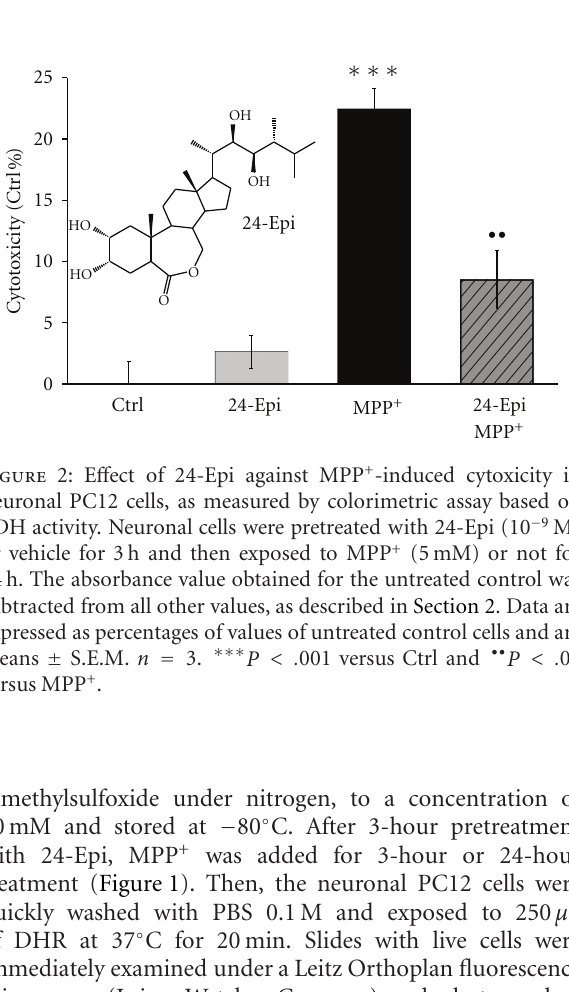
Figure 1: Experimental design to examine the e ff ect of 24-Epi on MPP + -induced cellular death and oxidative stress. Cells were pretreated with 24-Epi (10 − 9 M) or vehicle 3h before MPP + administration. Neuronal cells were harvested at the indicated time periods after each experimental methodology described in Section 2.